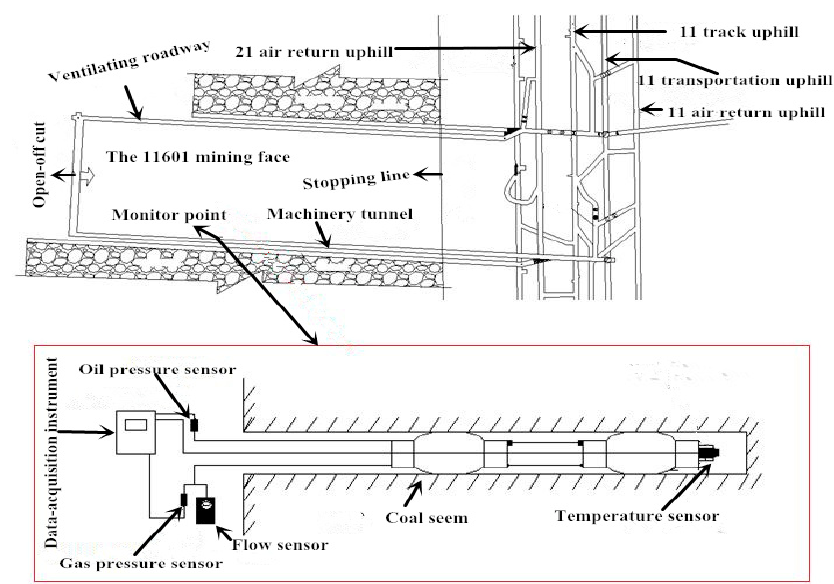
Figure 6. The location of 11,061 mining face and measuring point in Liang Bei coal mine.